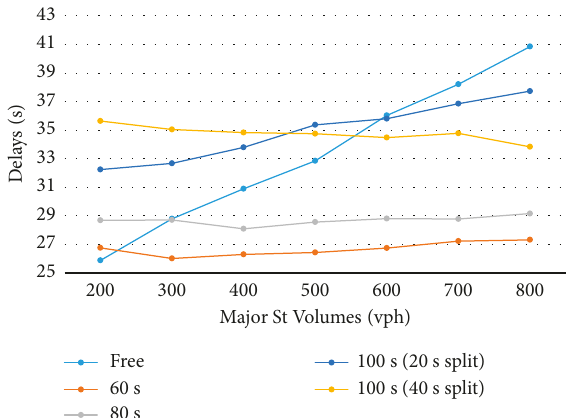
Figure 2: Average delay under minor street volume of 50 vph.